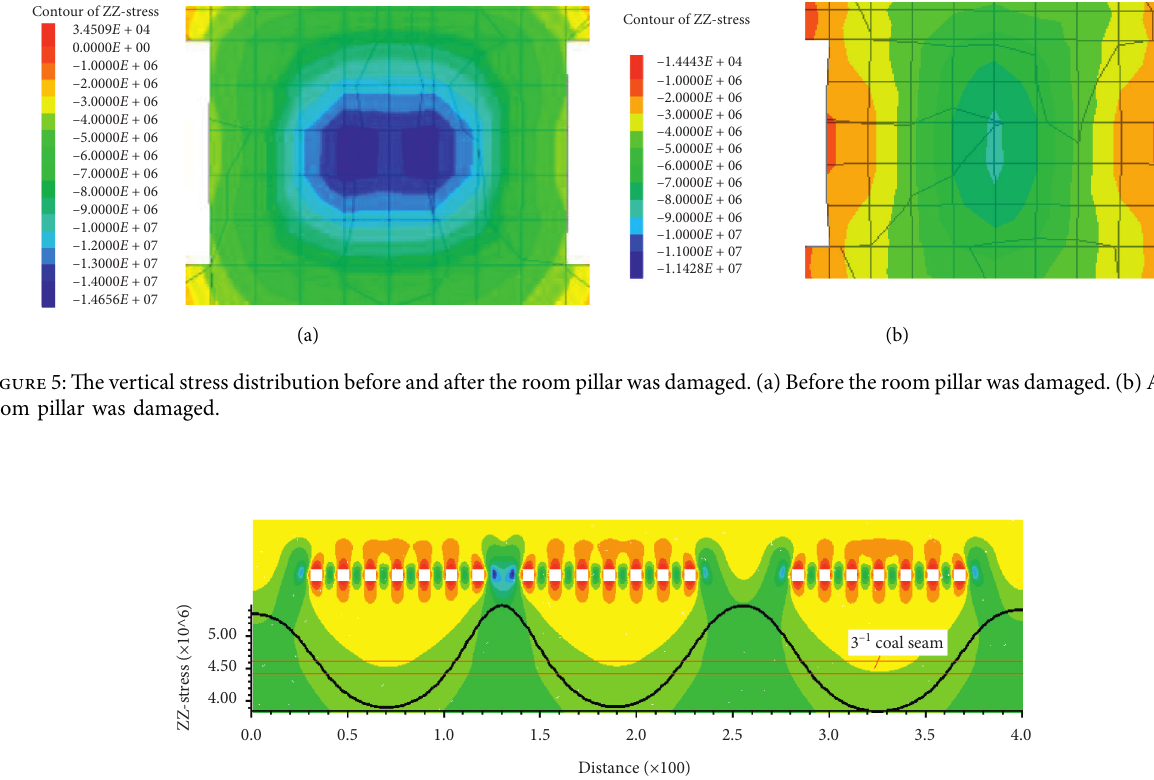
Figure 6: Vertical stress distribution of the coal seam 3 − 1 under the mining influence of coal seam 2 − 2 .